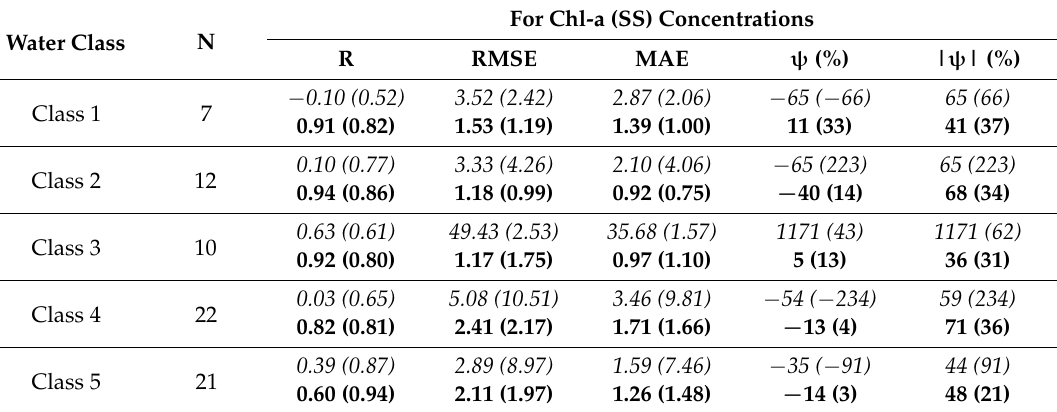
Table 6. Summary of the validation parameters for Chl-a and SS concentrations computed using the validation dataset for each